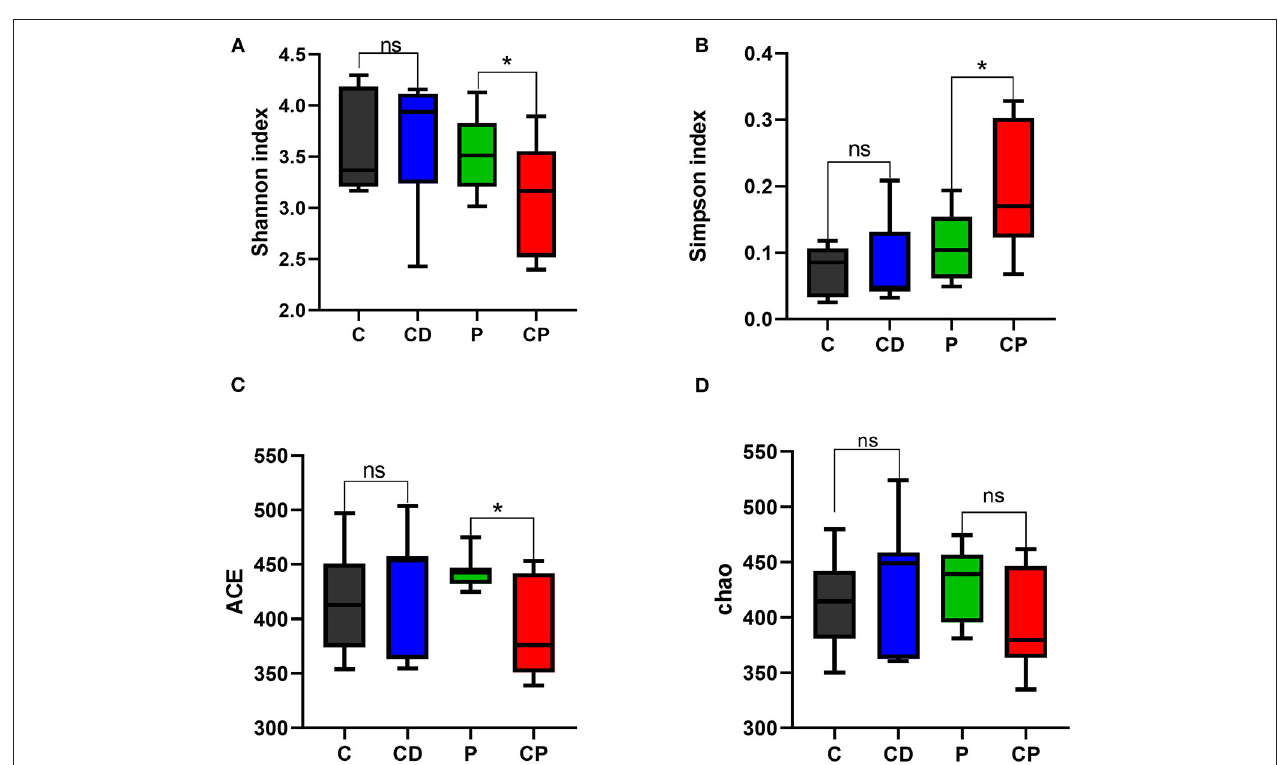
FIGURE 6 | Shannon (A) , Simpson’s (B) , ACE (C) , and Chao (D) indexes in α -diversity analysis. * P < 0.05; ns P > 0.05 ( n = 10).